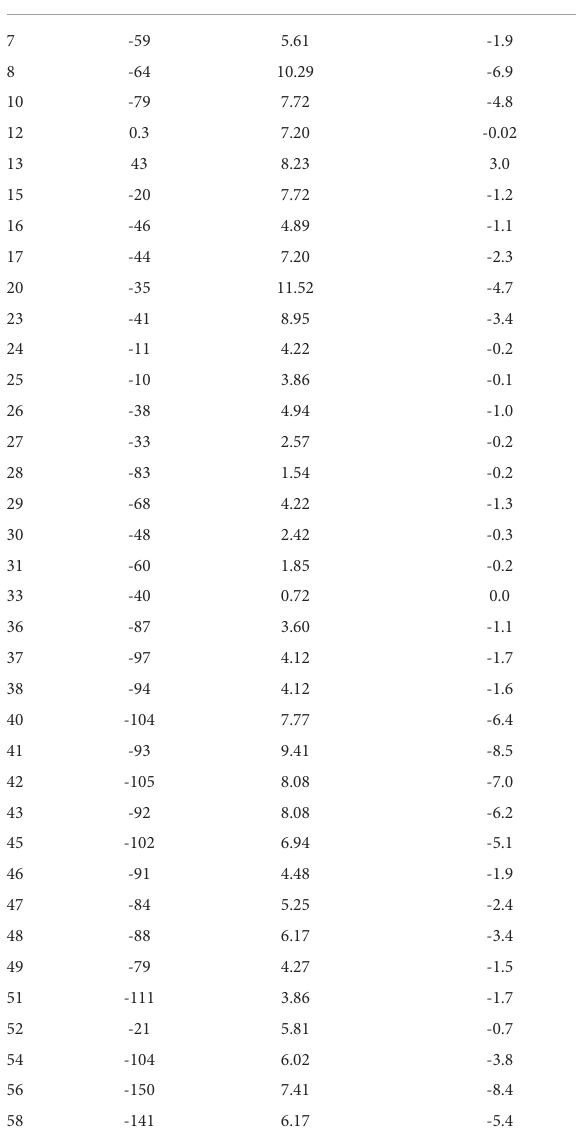
TABLE 3 Air – sea CO 2 gradient ( D pCO 2 ), wind speed and estimated